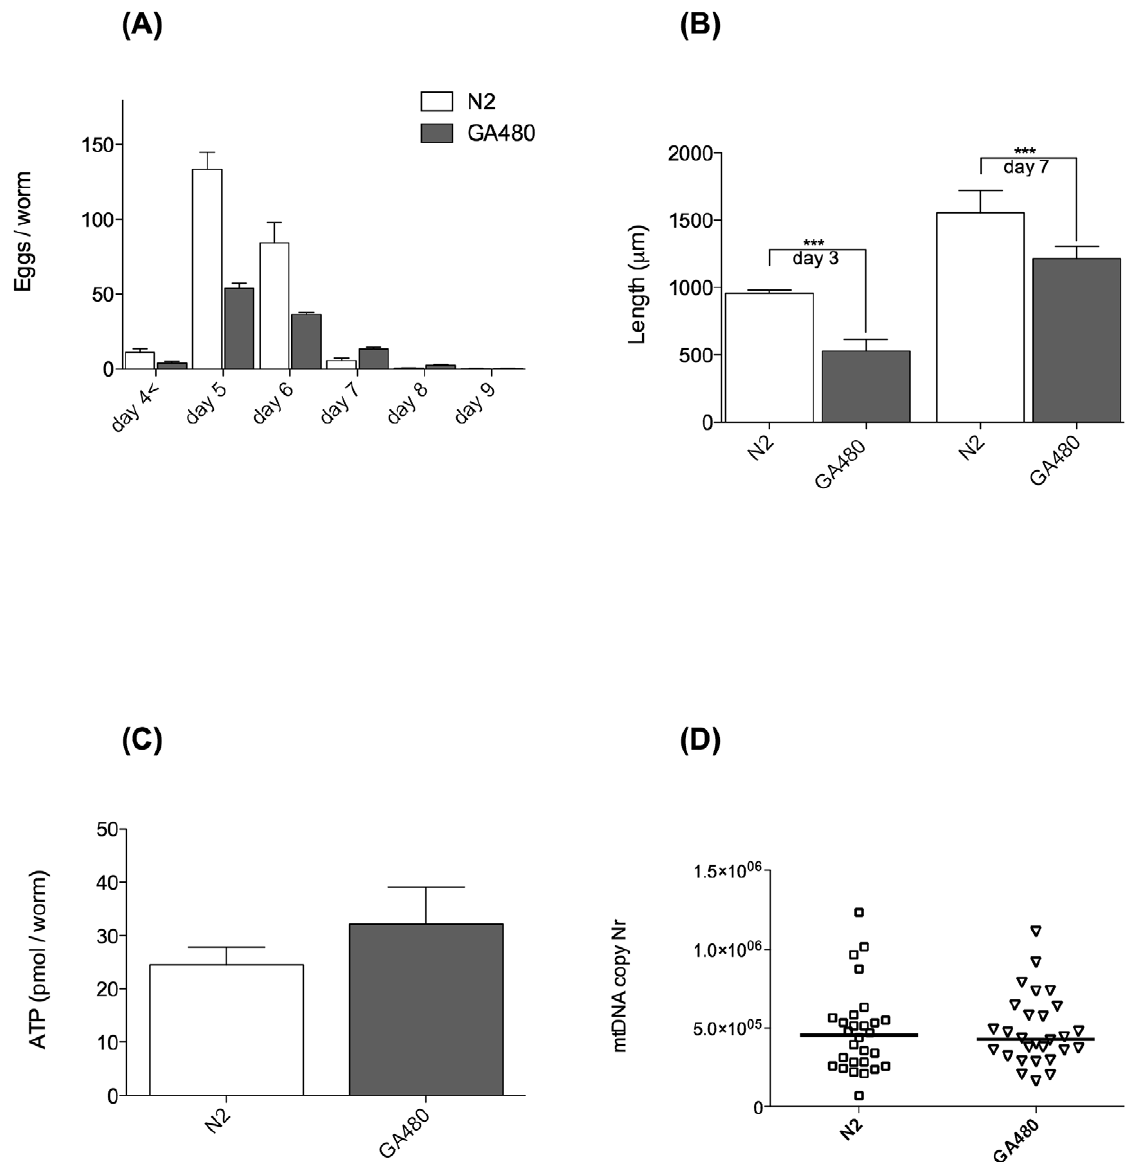
Figure 5. Phenotypical fitness comparison of GA480 sod-2/sod-3 double mutant strain ( sod-2 ( gk257 ) I, sod-3 ( tm760 )) with WT N2 C. elegans . ( A ) Egg laying study comparing number of eggs laid daily by GA480 and WT worms (n=10 each). GA480 produce significantly less eggs (total 222 vs. 107 eggs per adult on average, (P , 0.0001, ANOVA with Tukey’s post-test)). ( B ) GA480 worms grow slowly and are significantly smaller than WT on both day 3 and day 7 (both P , 0.0001, Student’s t-test). ( C ) Steady state levels of ATP per worm on day 4 are not significantly different between GA480 and WT worms (P=0.18, Student’s t-test). ( D ) No difference in mtDNA copy number in individual worms between GA480 and WT. Copy number was assessed on day 2 post bleach (n=28 animals each), to minimise confounding effects of oocytes as much as possible. The median is not significantly different between GA480 and WT (P=0.44, Mann-Whitney test).